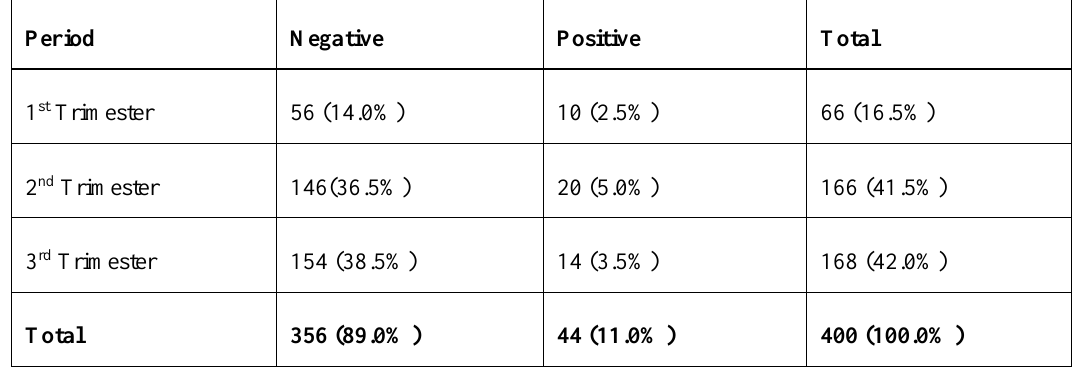
Table 8 . Prevalence of hepatitis B in different trimesters among pregnant women in